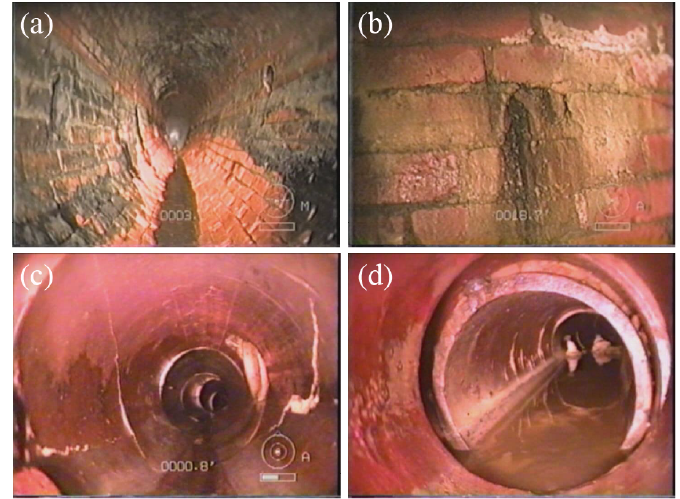
Figure 3. CCTV images of damaged pipes within the sewer network of Hoboken. ( a , b ) egg-shape conduit in bricks; ( c , d ) circular conduit in